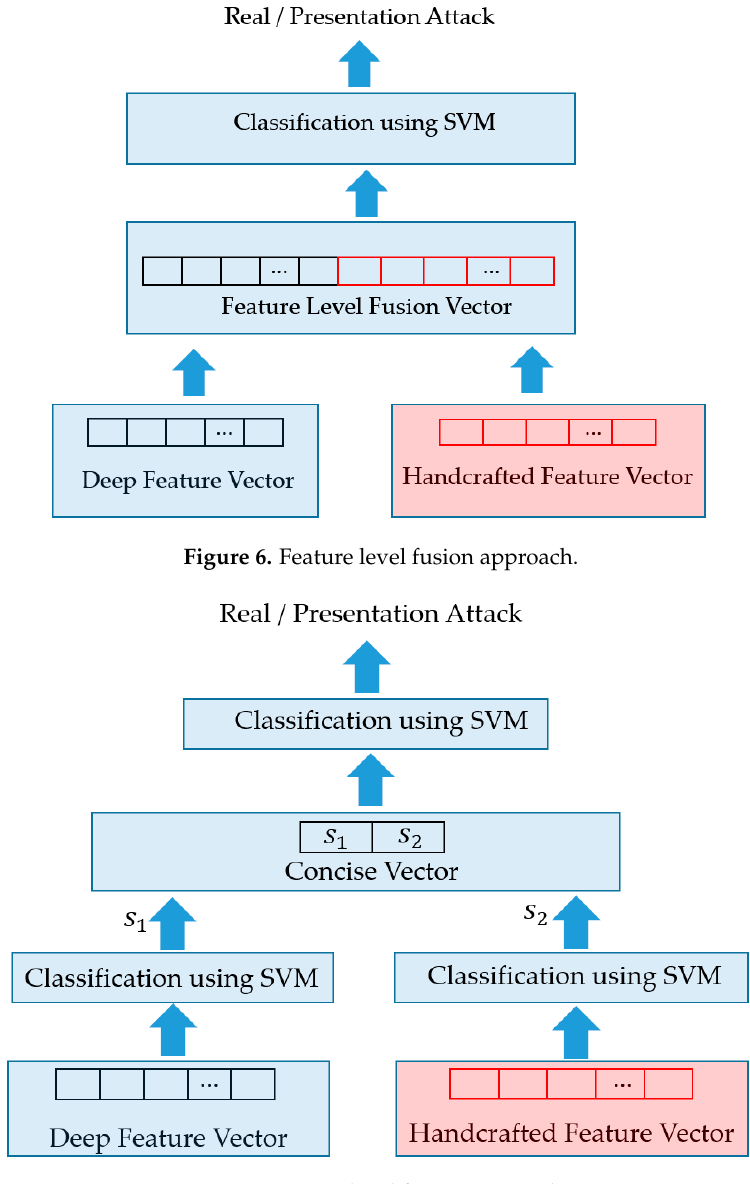
Figure 7. Score level fusion approach.